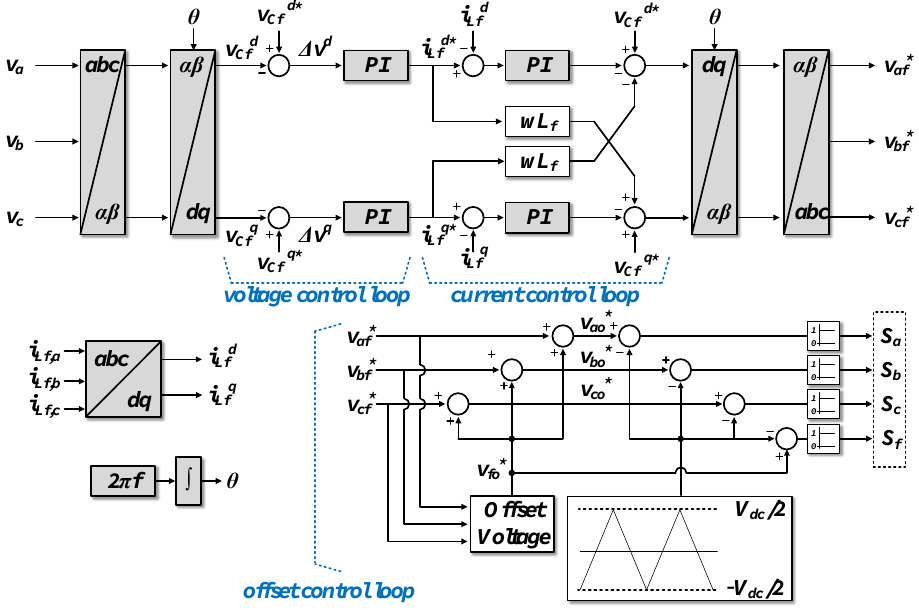
Figure 3. Block diagram of 4-leg CVCF inverter using off-set control.